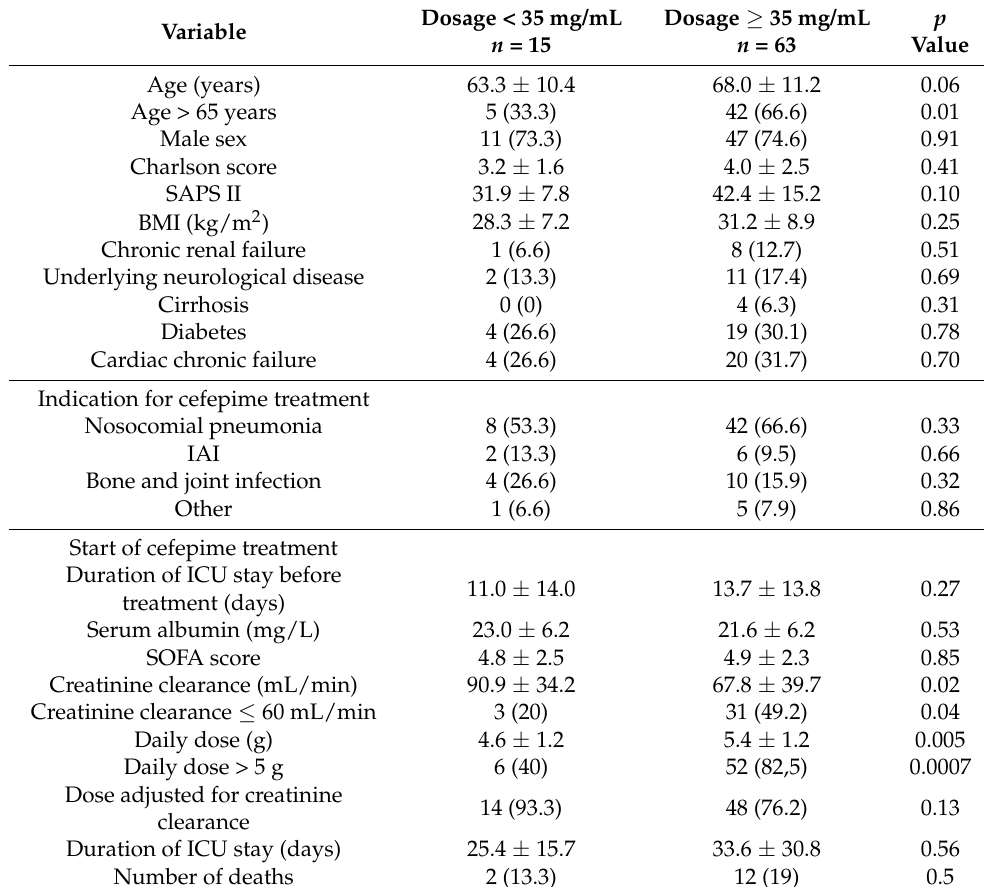
Table 1. Clinical characteristics of patients and predisposing factors associated with overdosing of cefepime.